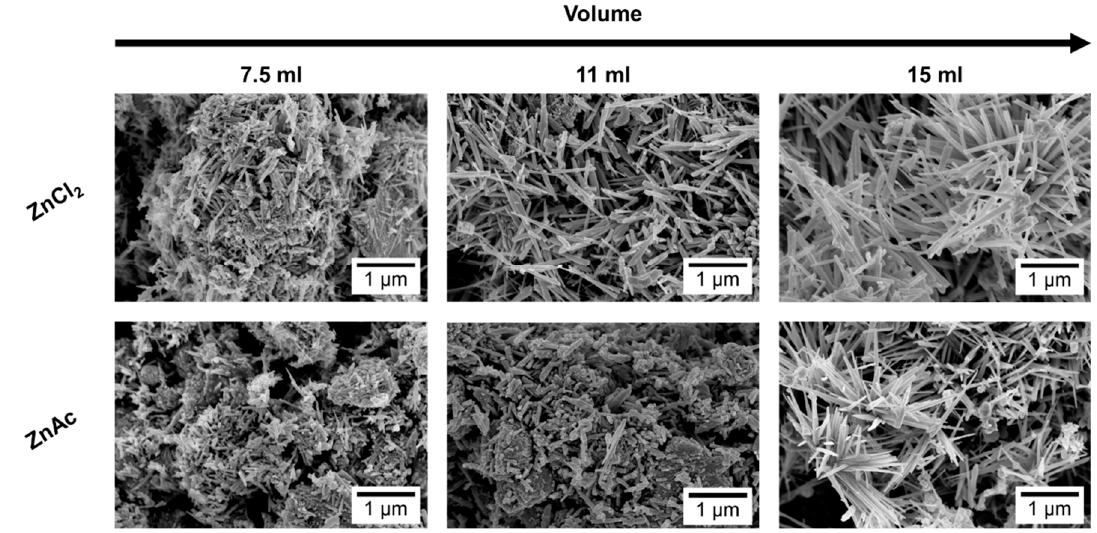
Figure 2. SEM images of nanostructures obtained for different reaction mixture volumes, 7.5 mL, 11 mL, and 15 mL, using ZnCl 2 and ZnAc as zinc precursor.